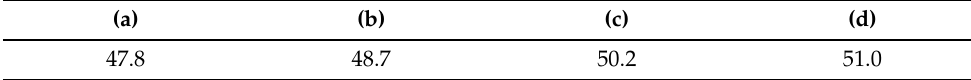
Table 4. Ablation study on various structures with the MPJPE (mm).